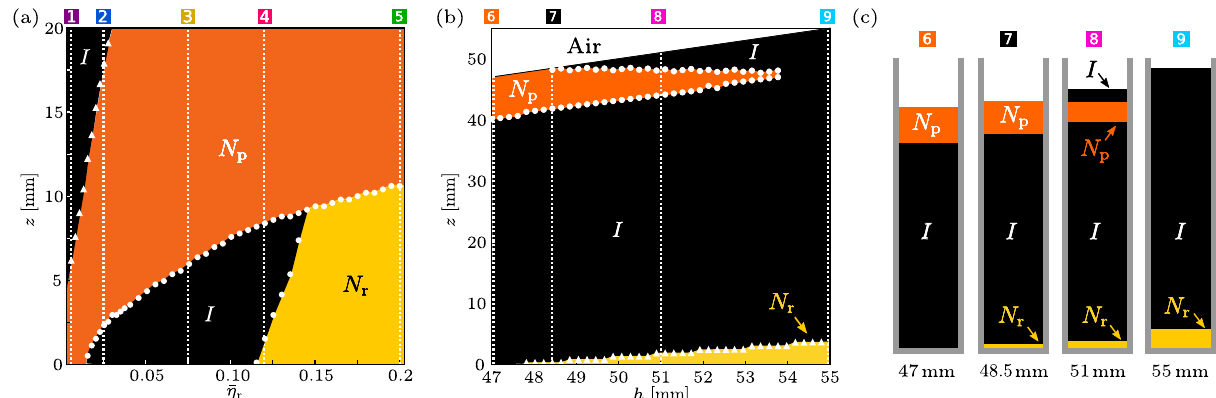
for samples with fi xed height h = 20 mm and r